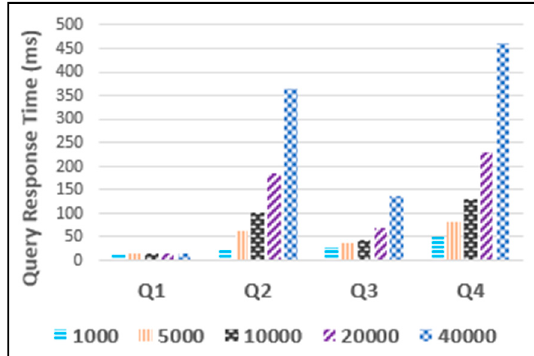
Figure 27. Query response time vs. number of registered entities.